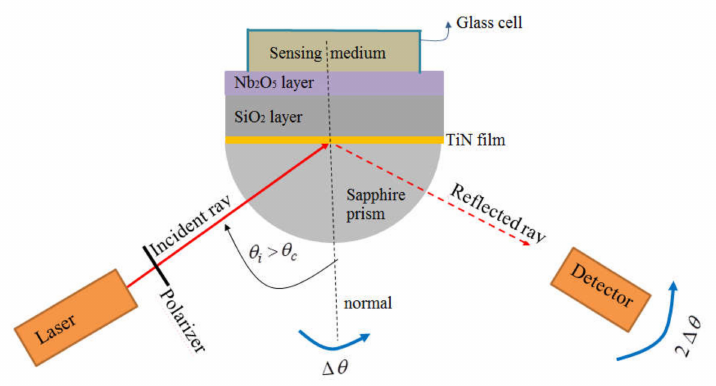
Figure 3. Schematic of the experimental setup for Reflectance vs. Angle-of-incidence measurements in the Kretschmann configuration; sensor and detector are mounted on two coaxial rotatory tables rotating in the plane of the figure, keeping the configuration theta-2theta; the incident ray is fixed respect to the laboratory.